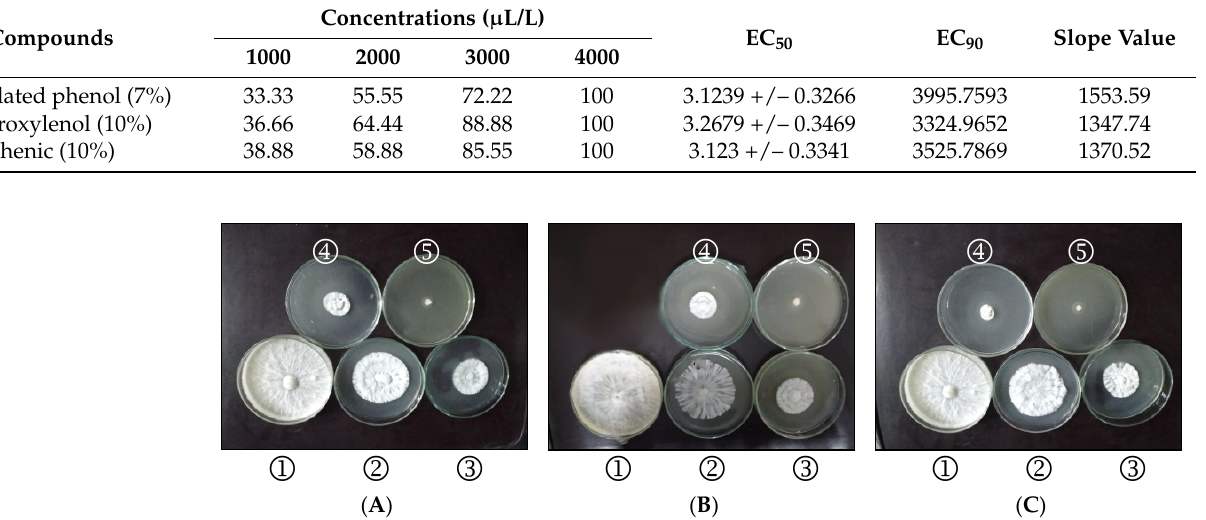
Table 4. Physicochemical properties of spray solution at the recommended field dilution rate (1.5%).